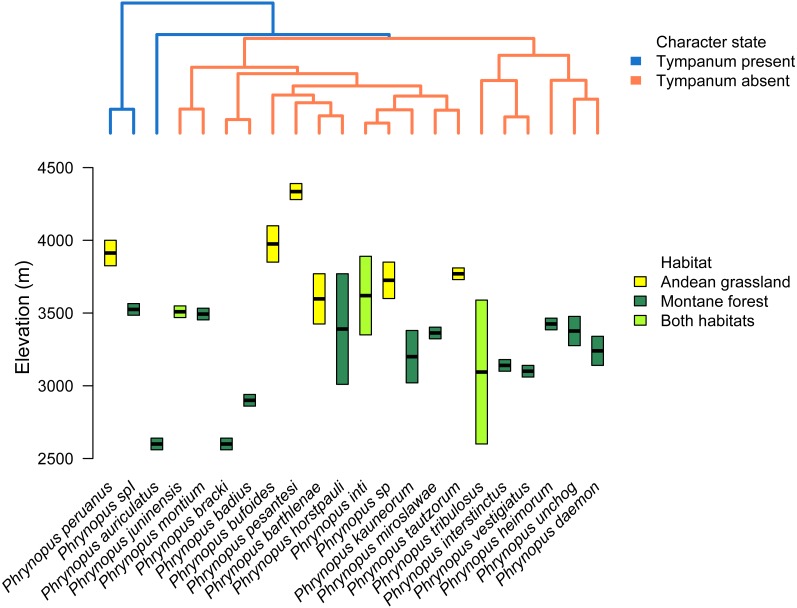
Tree and elevational ranges.Elevational distribution and habitat use are not related to tympanum condition in Phrynopus. The species tree (obtained with *BEAST) depicting the relationship among 22 species of Phrynopus (top) is color-coded according to the presence (blue) or absence (orange) of tympanic membrane and annulus. The elevational ranges (bottom) are color-coded according to species’ primary habitat: Andean grassland (yellow), montane forest (dark green), and both habitats (light green). The elevational midpoint is denoted by a black bar.